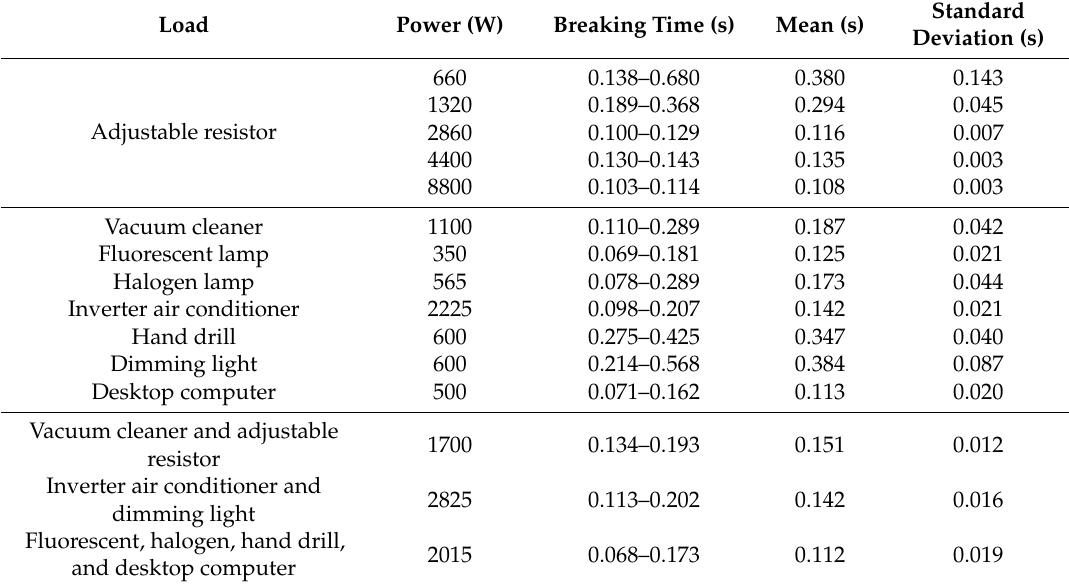
Table 1. Test results of AFDD